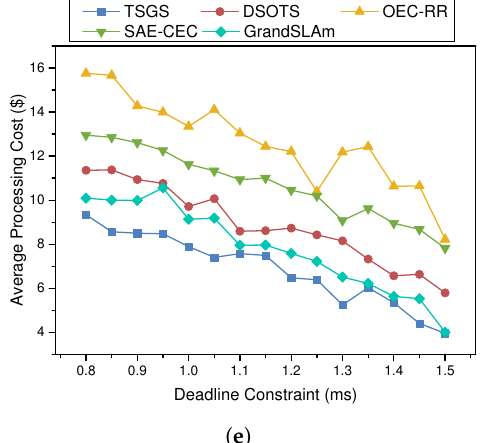
Figure 6. The impact of deadline changes on SLA violation rate, time, and cost. ( a ) SLA violation rate; ( b ) SLA violation rate (DSOTS vs. TSGS vs. GrandSLAm); ( c ) average processing time; ( d ) average waiting delay; and ( e ) task processing